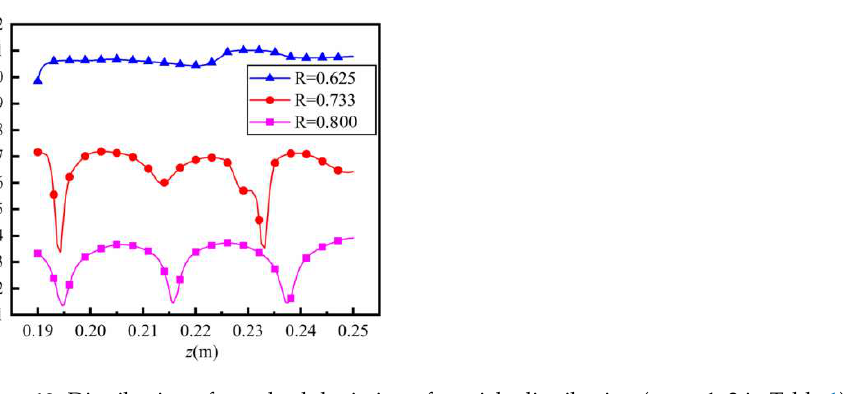
Figure 10. Distribution of standard deviation of particle distribution (cases 1–3 in Table 1).